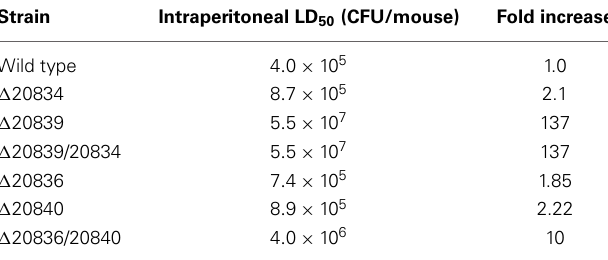
Table 3 | Effect of the mutation on the lethality to